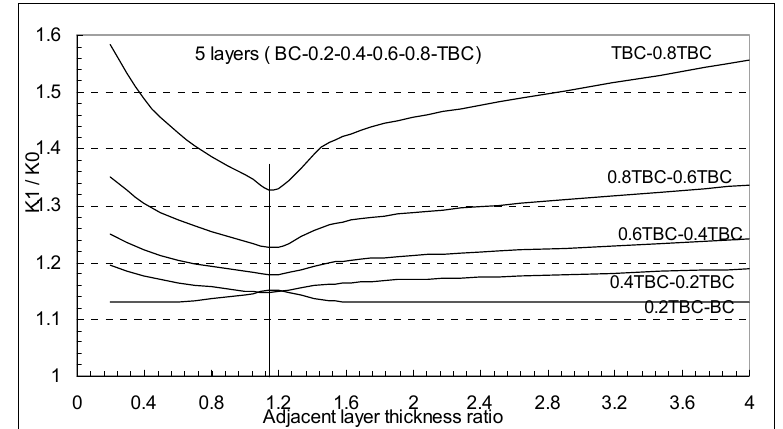
/ K 1 0 for 5-layer FGM.